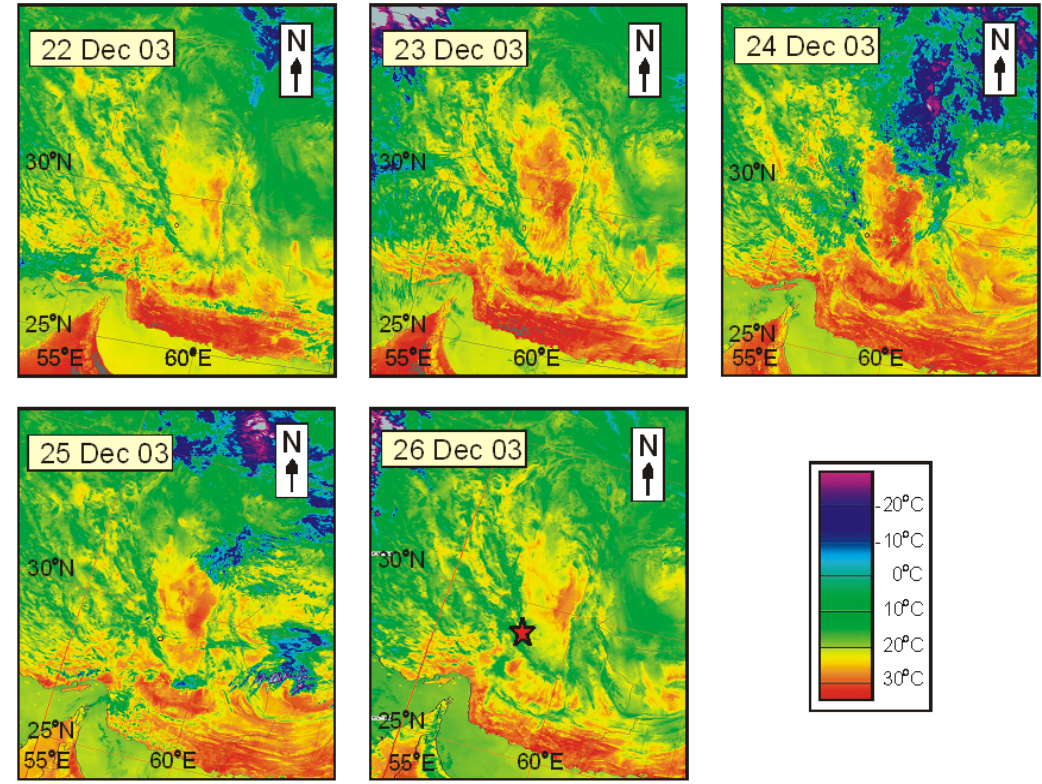
Figure 14. Thermal anomalies associated with Bam earthquake (M = 6.6, 26 December 2003, Iran). NOAA-AVHRR daytime data, star indicate earthquake epicenter [41].